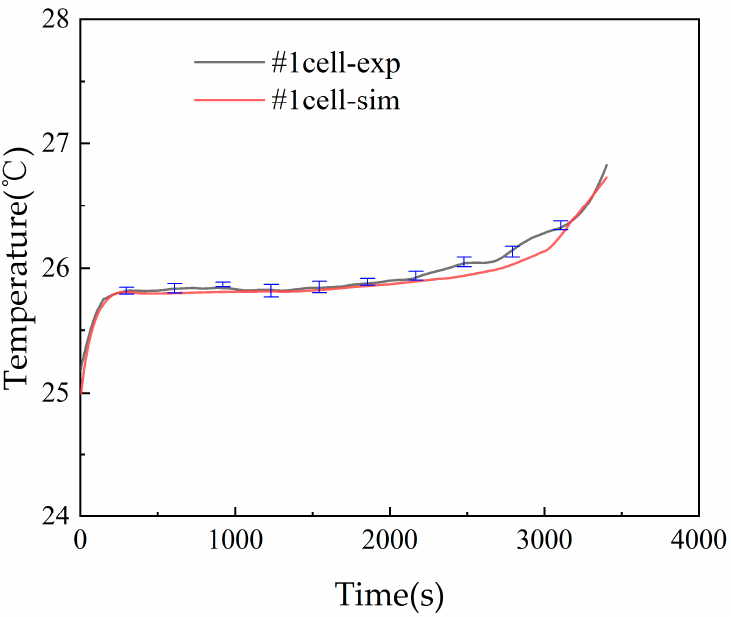
Figure 4. Comparison of experimental and simulation results for the temperature of cell #1 in the ba tt ery